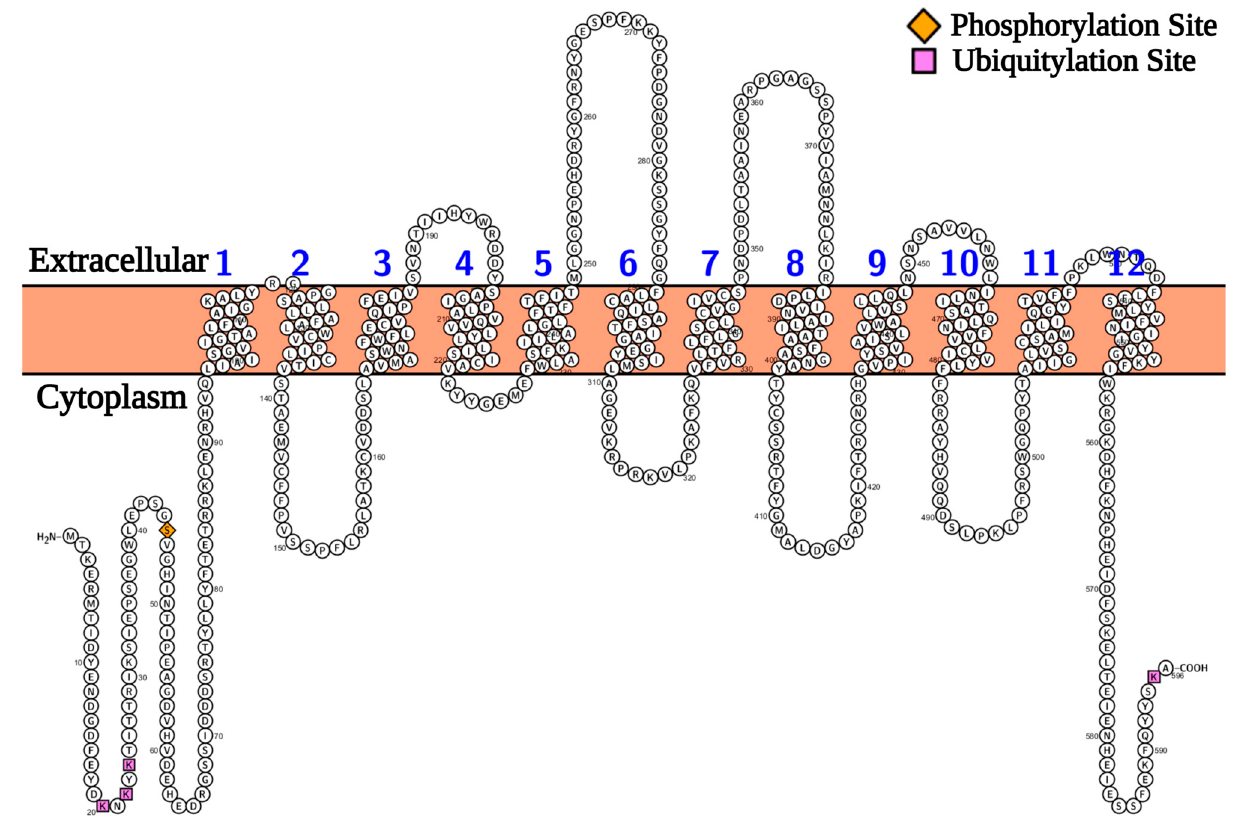
Figure 1. Protter representation of Agp2 transmembrane topology comprising 12 transmembrane helices. The ubiquitylation sites (Lysine 20, 22, 24, and 595) and the phosphorylation site (Serine 45) are indicated as purple square and orange diamond, respectively.